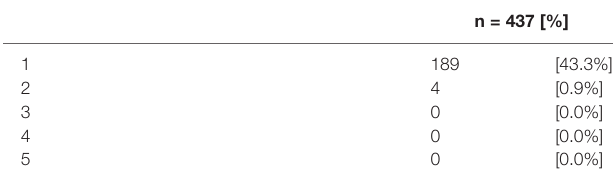
TABLE 2 | Treatment